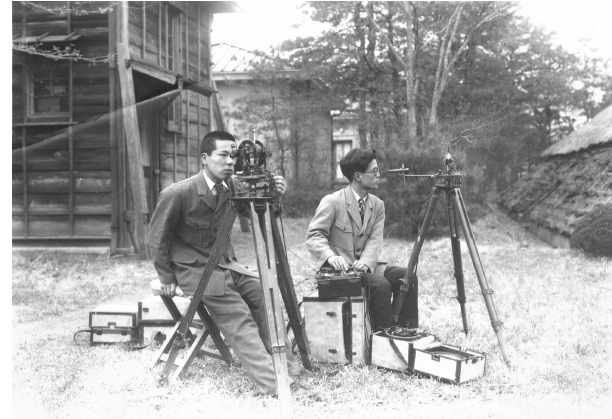
Figure 11. Hydrographic Bureau theodolite for the horizontal force during an observation in 1947 at Kakioka (photo supplied by Kakioka Magnetic